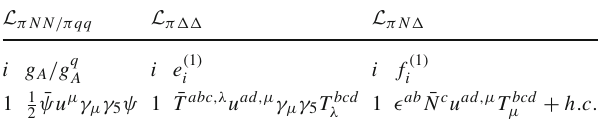
Table 1 The O ( p 1 ) chiral-invariant terms of the Lagrangians L π NN , L π L π(cid:2)(cid:2) , and L π qq , N (cid:2) . Their corresponding coupling constants are ( 1 ) ( 1 ) g A , g q , e , and f , respectively. ψ in L π NN /π qq means N /ψ q A i i